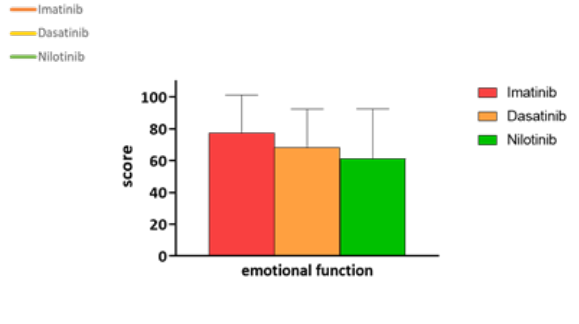
Table 3. Patients’ reported outcomes—additional questions.